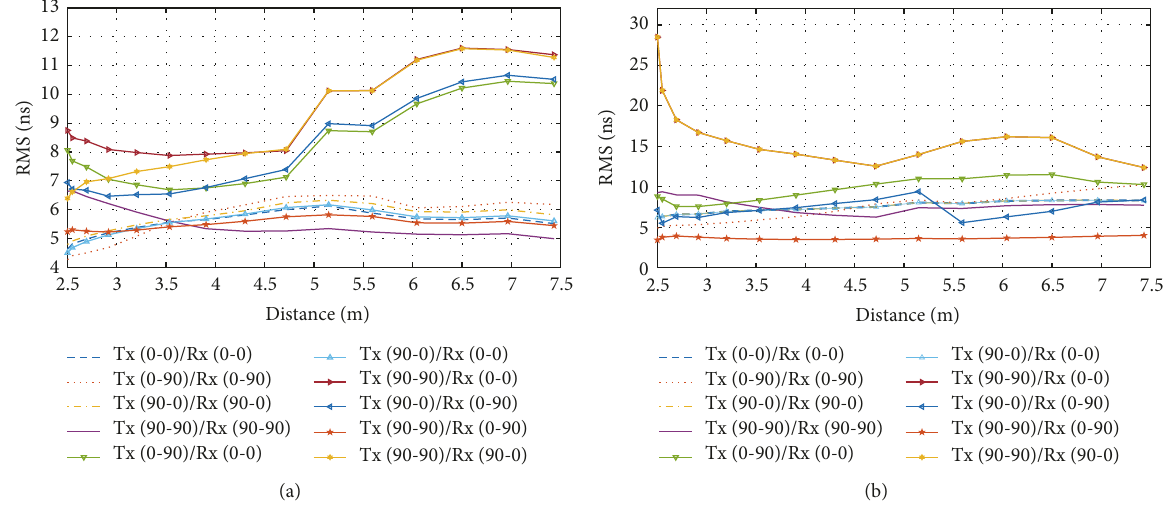
Figure 11: RMS delay spread for the two antennas in the LOS scenario: (a) 3D cubic antenna and (b) dipole antenna.